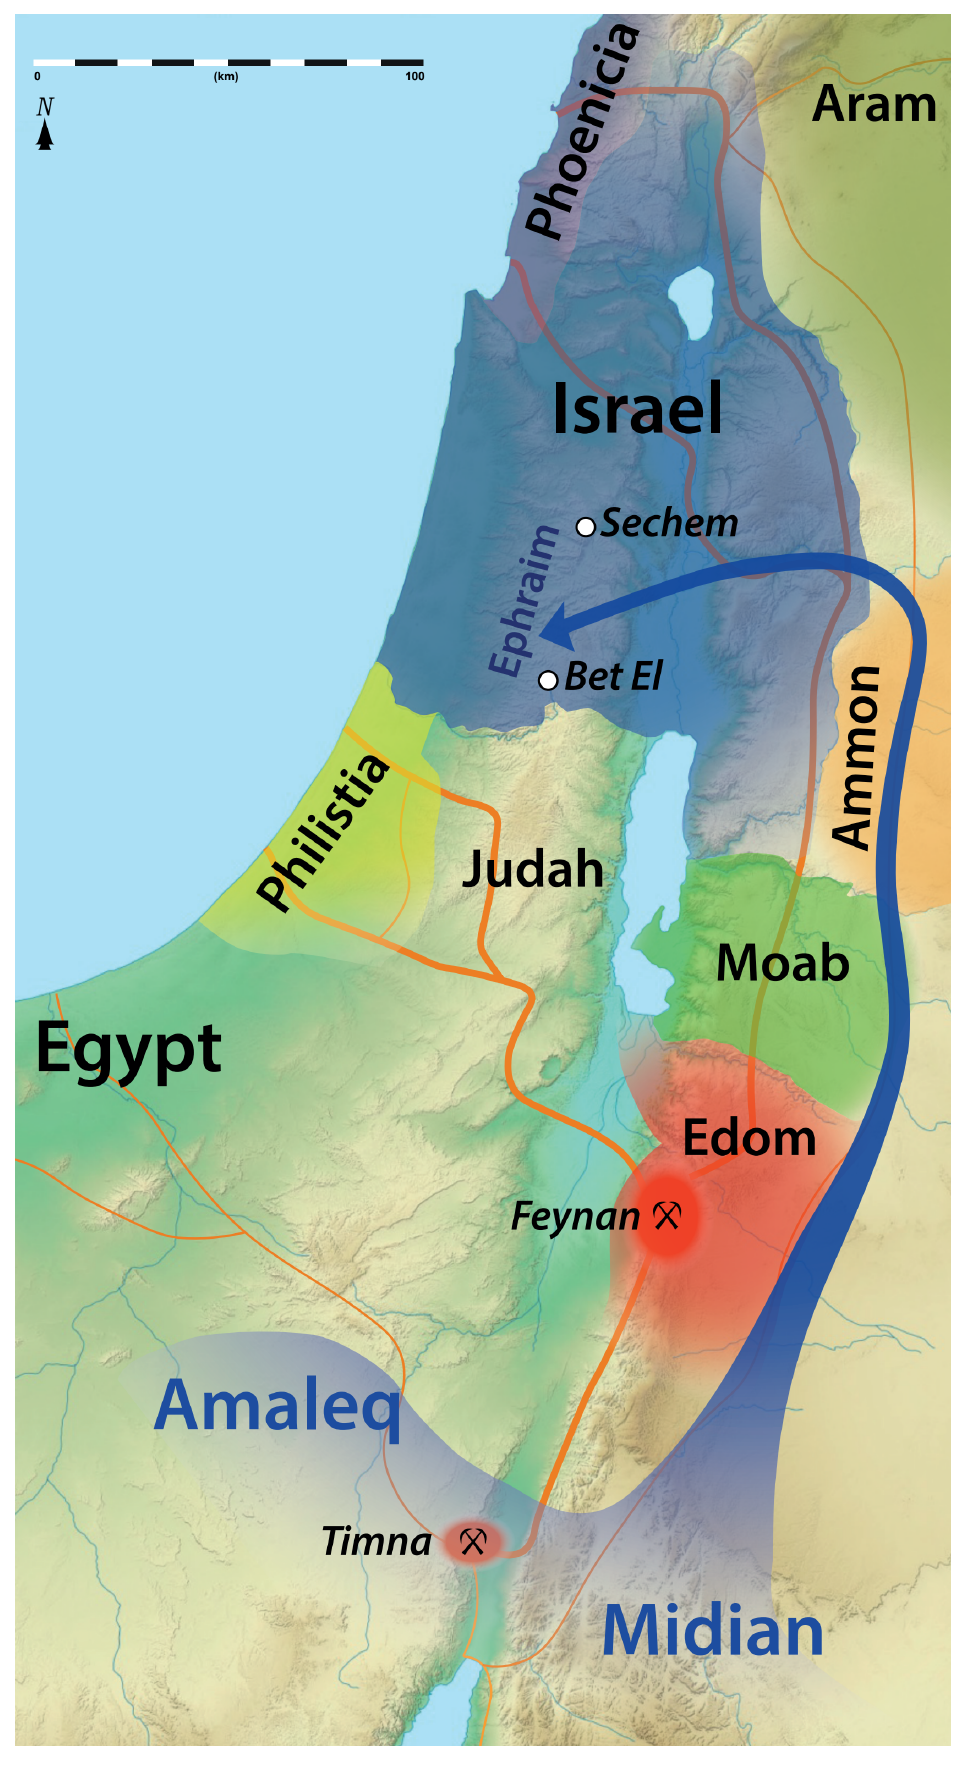
Figure 3 The emergence of new nations in Southern Levant in the early Iron